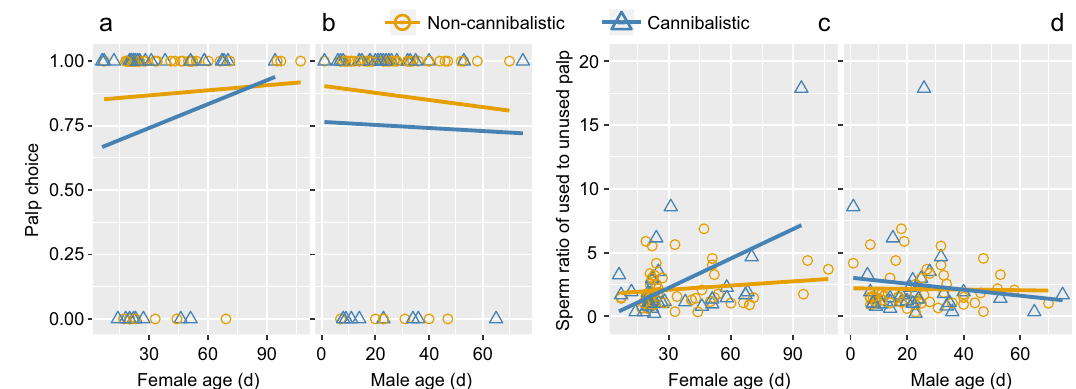
Fig. 2 Effect of the interactions of sexual cannibalism with female post-maturity age and with male post-maturity age on how frequently males chose the palp with more sperm for their fi rst insertion. a Signi fi cantly more males chose the palp with more sperm when mating with older and cannibalistic females (blue line). b Younger males chose the palp with more sperm when mating with non-cannibalistic females (orange line). c Males selected the palp with a signi fi cantly higher sperm ratio when mating with an older female only if she was cannibalistic (blue line). d Younger males selected the palp with a signi fi cantly higher sperm ratio with a cannibalistic partner (blue